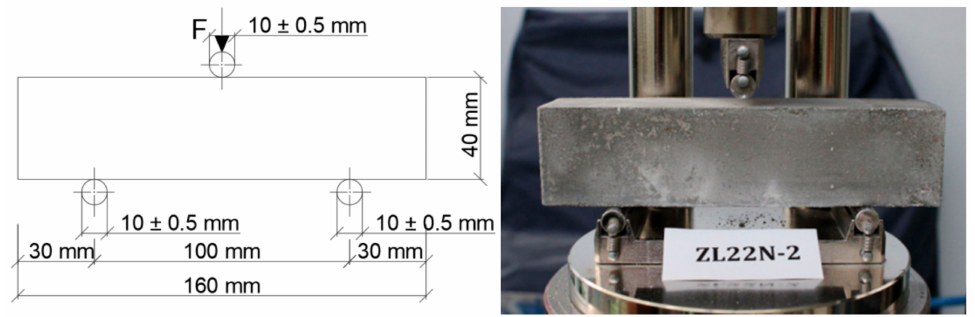
Figure 5. A loading arrangement for testing flexural strength of cement mortar according to EN 196-1